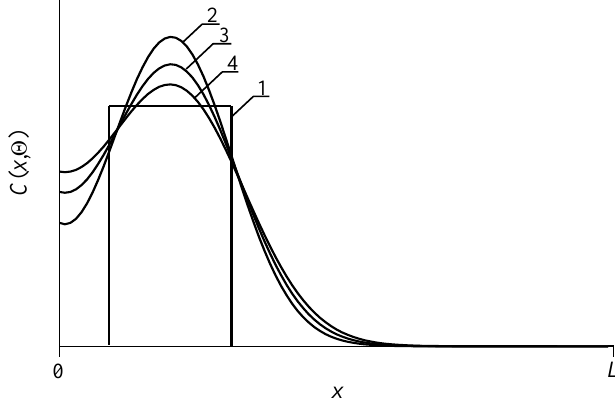
Fig. 5. Spatial distributions of dopant in heterostructure after ion implantation.